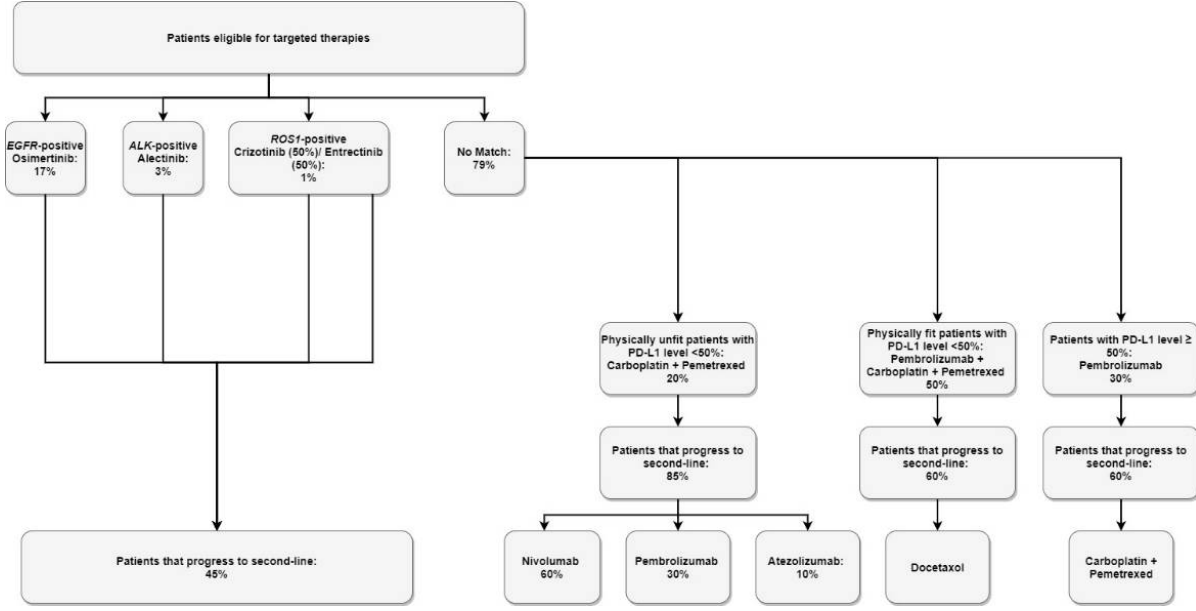
Figure 3. Treatment distribution: targeted therapies.